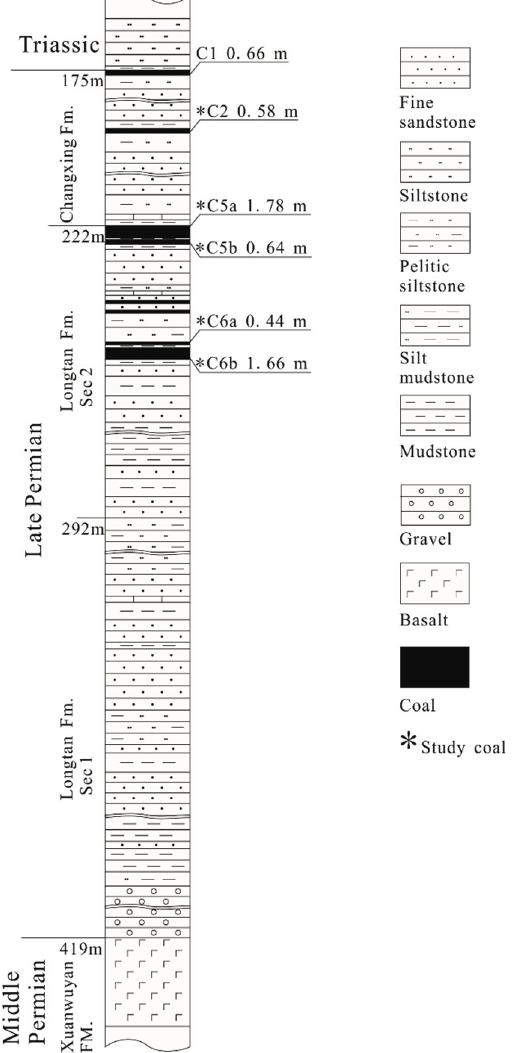
Figure 2. Stratigraphic column of the drill core from the Mahe mine, Zhaotong coalfield, northeastern Yunnan Province,